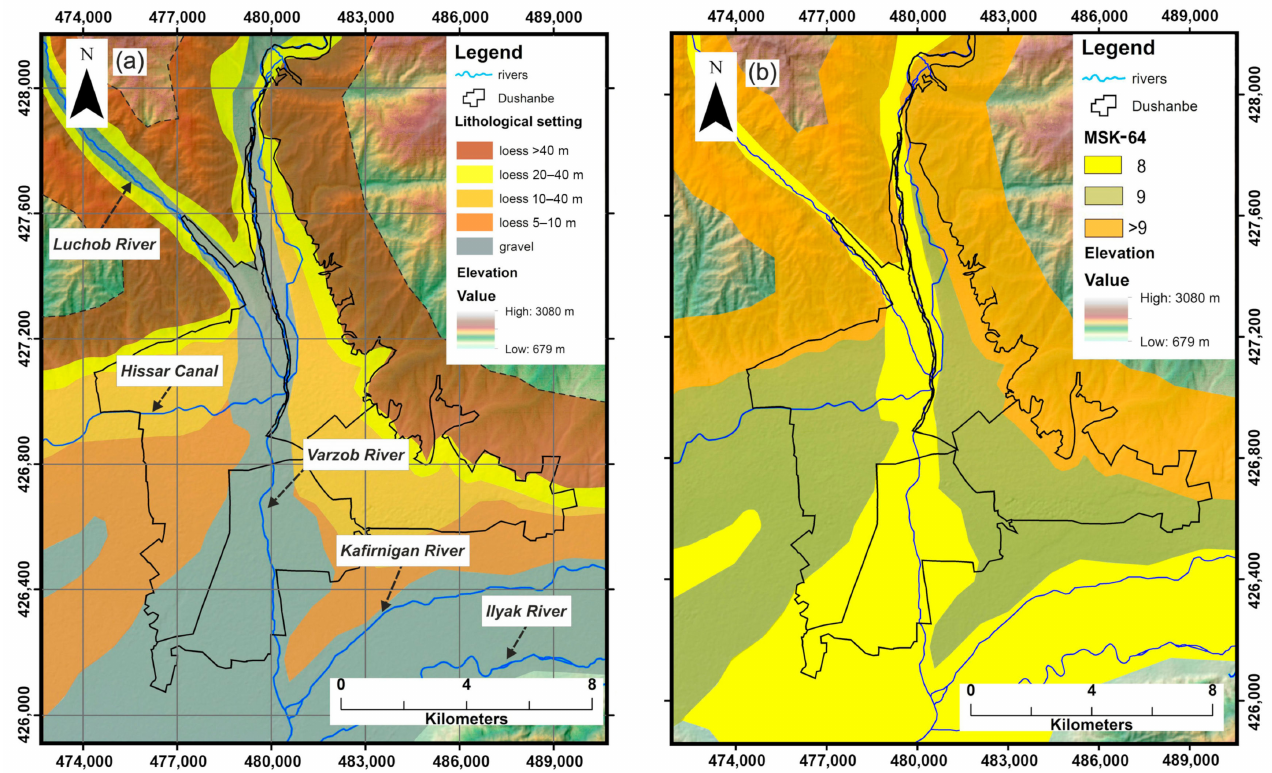
Figure 2. ( a ) River system and lithology in the area of Dushanbe (after [28]) and ( b ) seismic microzonation of Dushanbe by [29] based on the acoustic stiffness of the soils in terms of the MSK-64